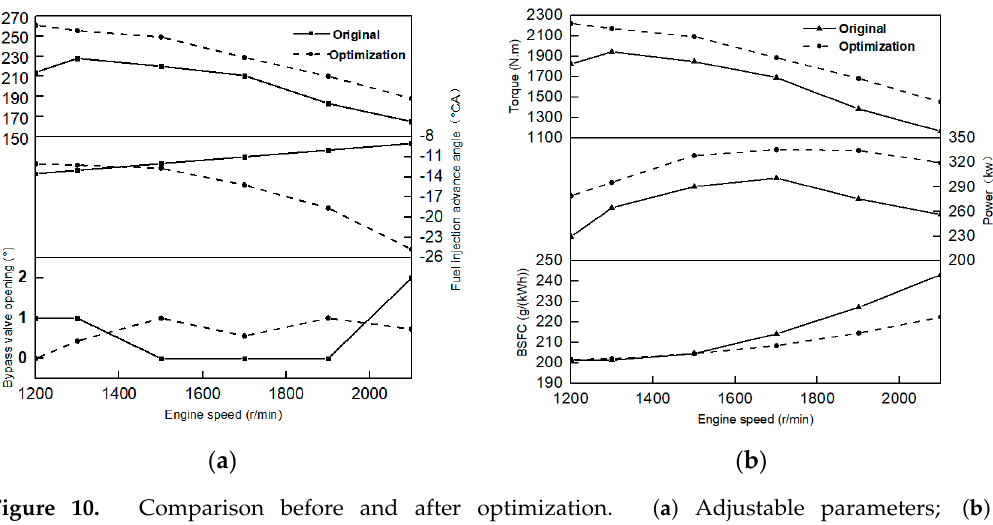
Figure 10. Comparison before and after optimization. ( a ) Adjustable parameters; ( b ) engine performance.